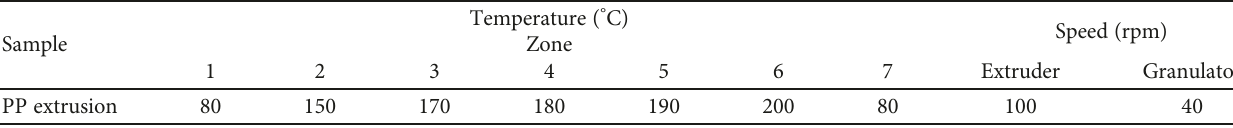
Table 1: PP reprocessing conditions in double screw